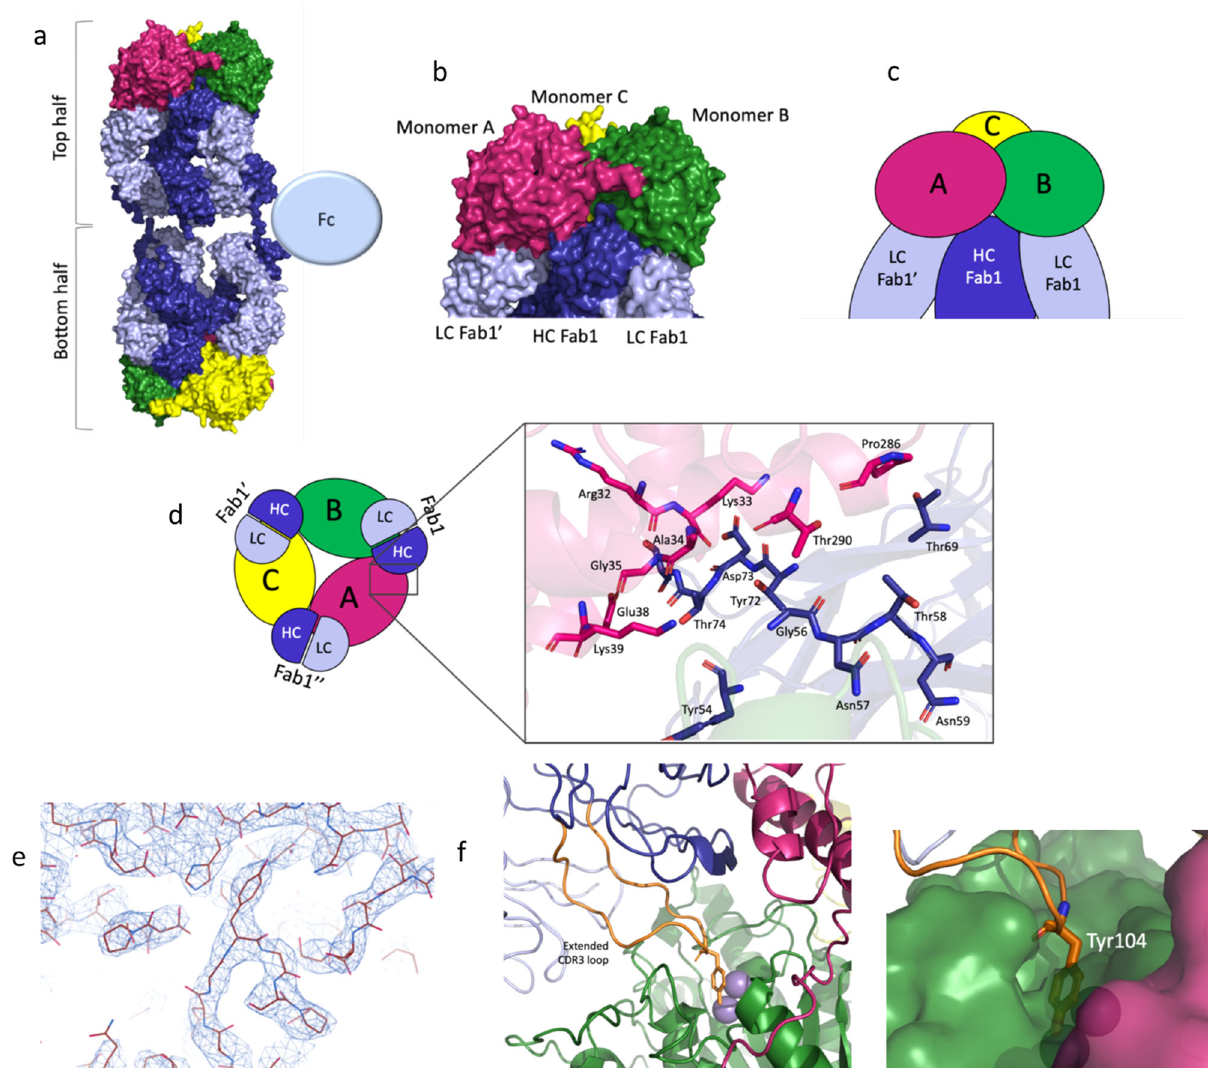
Fig. 2 Epitope determination for mAb1, mAb2 and mAb3. This panel shows an overview of how the large 2:3 hArg1:mAb1 complex assembles. The three monomers of the hArg1 trimer are colored in green, pink, and yellow, and the mAbs colored in dark blue (heavy chain) and light blue (light chain). a A surface representation of the full complexes. b A closeup view of mAb1 ’ s interaction across two hArg1 monomers in surface representation. c A closeup view of the mAb1:hArg monomers in simpli fi ed cartoon representation. d The complex is viewed in a simpli fi ed cartoon form as viewed from the top. Each HC interacts with two hArg1 monomers while each LC interacts with only one hArg1 monomer; these interactions are symmetric around the trimer. A closeup view of the monomerA:HC surface interaction is provided. e A sample of the electron density at the hArg1:Fab interface is shown, highlighting the ability to con fi dently model all main chain and side chain atoms. f This class of mAbs are characterized by a very long CDR-3 loop (orange). Tyr104 (shown as sticks) extends into the hArg1 active site. The binuclear active site manganese ions are shown as purple